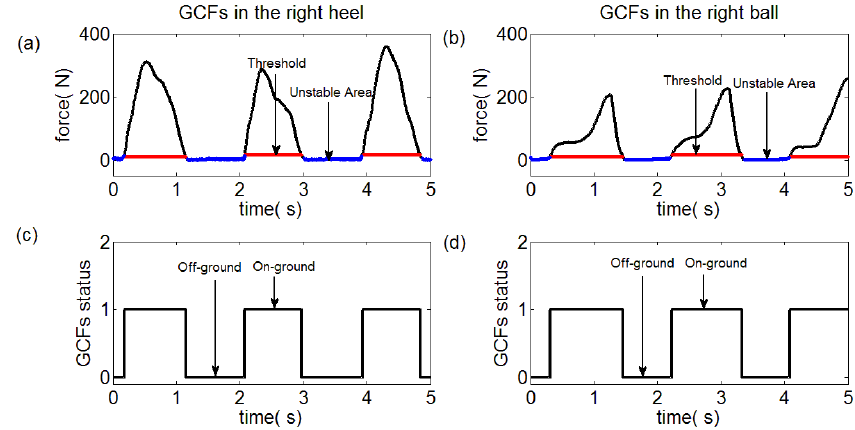
Figure 12. Status division for right ball and heel. ( a ) GCFs in the right heel, ( b ) GCFs in the right ball, ( c ) Status division for GCFs in the right heel, ( d ) Status division for GCFs in the right ball.